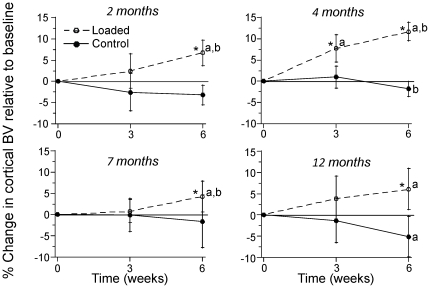
Mechanical loading increases cortical bone volume in all age groups.Cortical bone volume (BV) was assessed at the mid-diaphysis of loaded and contralateral control limbs using in vivo microCT at study baseline (0 weeks), middle (3 weeks) and end (6 weeks). Percent change was computed relative to the value at baseline. Cortical BV increased regardless of age in legs subjected to axial tibial compression. In each age group, significant temporal increases were observed in loaded tibias but not in contralateral controls. (n = 7–9; mean ± SD; * loaded different from control; a: different from 0 weeks; b: different from 3 weeks, p<0.05).